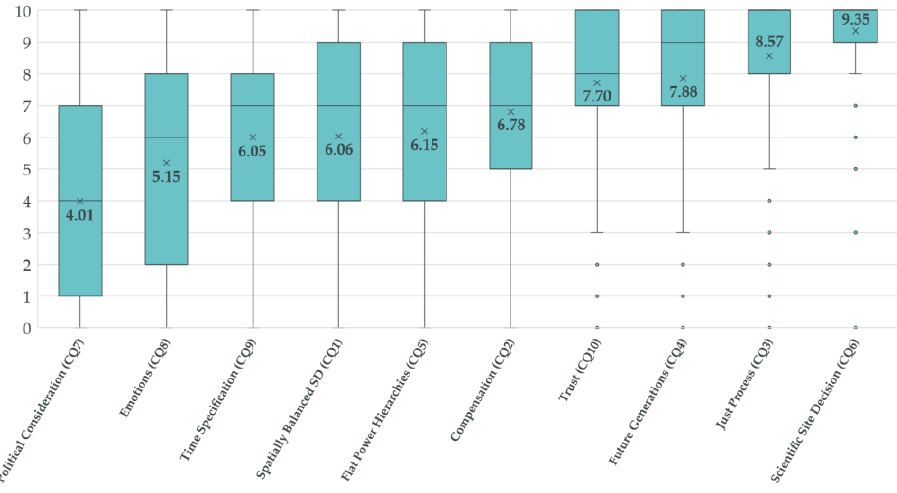
Figure 3. Factors contributing to a just perception of the repository site selection (CQ; own data).